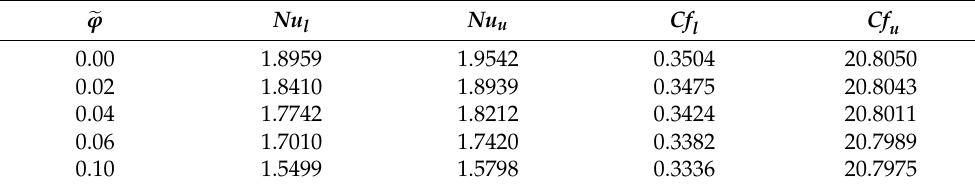
Table 4. Influence of nanoparticle volume fraction ( (cid:101) ϕ ) on physical quantities.